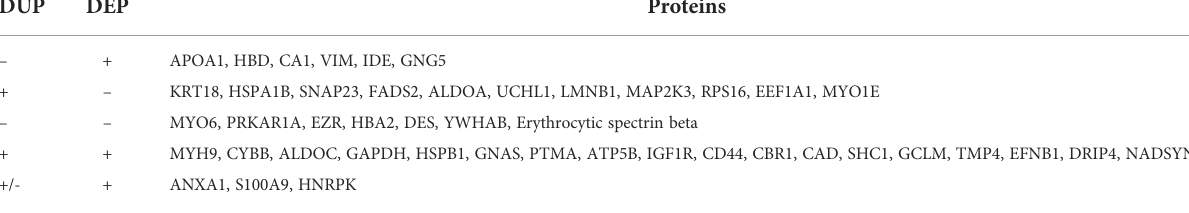
TABLE 2 The relationship between DUP and DEP in LSCC tissues compared to controls. DUP DEP